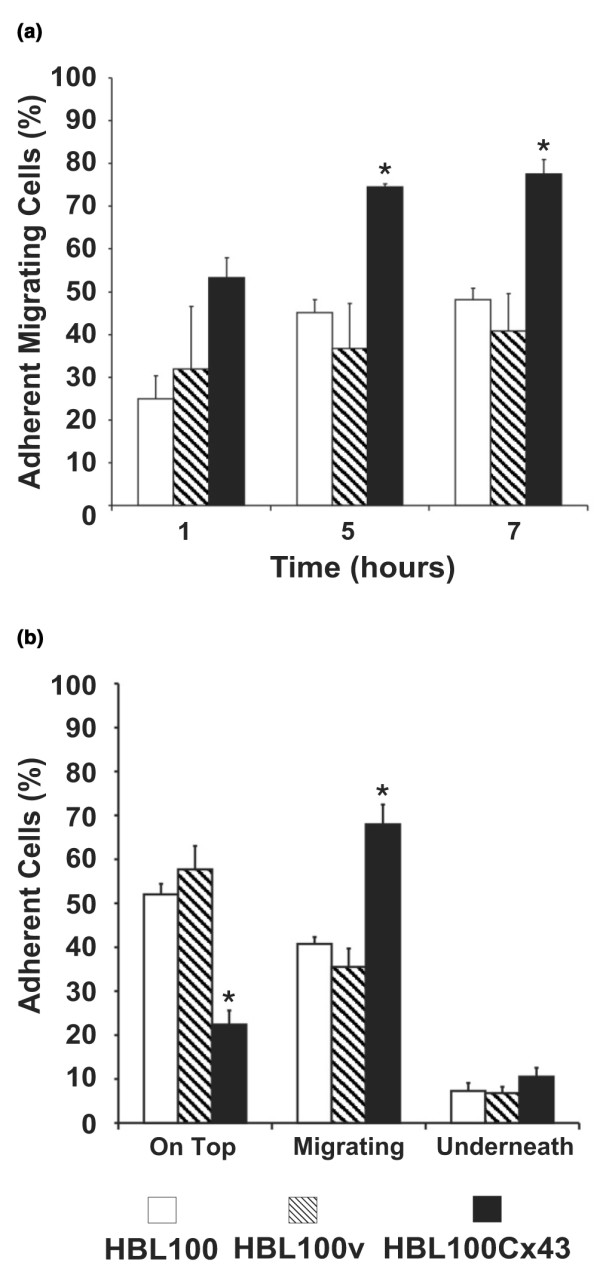
Connexin43 (Cx43) enhances tumor cell diapedesis. HBL100 and HBL100v cells or cells expressing functional Cx43 (HBL100Cx43) were co-cultured with HMVEC monolayers for 1, 5 and 7 h. (a) Adherent cells in the process of diapedesis and cells that had completed transmigration were scored together as migrating. Compared to HBL100v or HBL100 wild-type cells a two-fold increase in diapedesis of HBL100Cx43 cells was seen at 1, 5 and 7 h. (b) At 7 h the relative proportion of cells at different stages of migration was evaluated. Compared to control cells, the observed two-fold increase in the number of transmigrating HBL100Cx43 cells correlated with a two-fold decrease in the number of HBL100Cx43 cells located on top of the monolayer. No significant difference in the proportion of cells underneath the endothelium was observed between the Cx43 expressing and non-expressing HBL100 cells. Data are expressed as the mean percentage ± SEM of three independent experiments performed in triplicate (*p < 0.05).